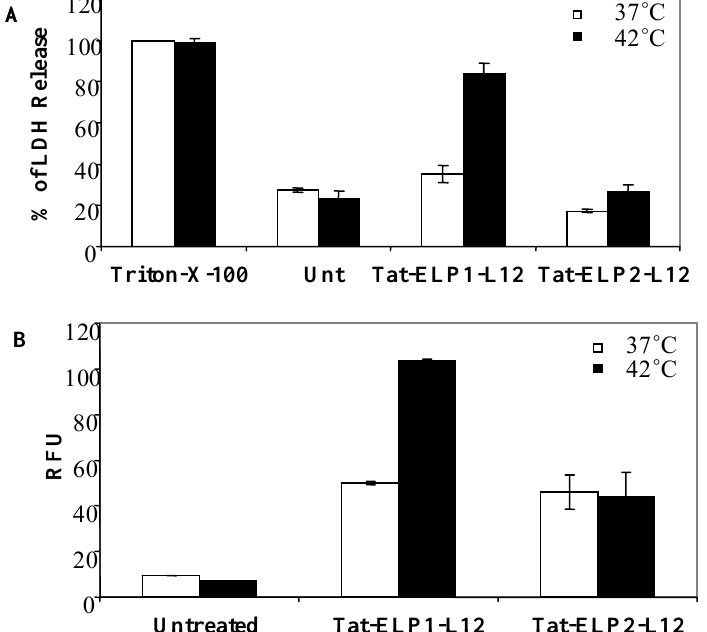
Figure 3. Effect of Tat-ELP1-L12 treatment on membrane